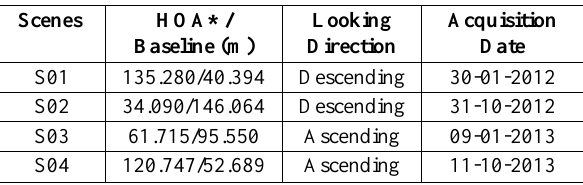
Table 3. TanDEM-X CoSSC Data (*Height of